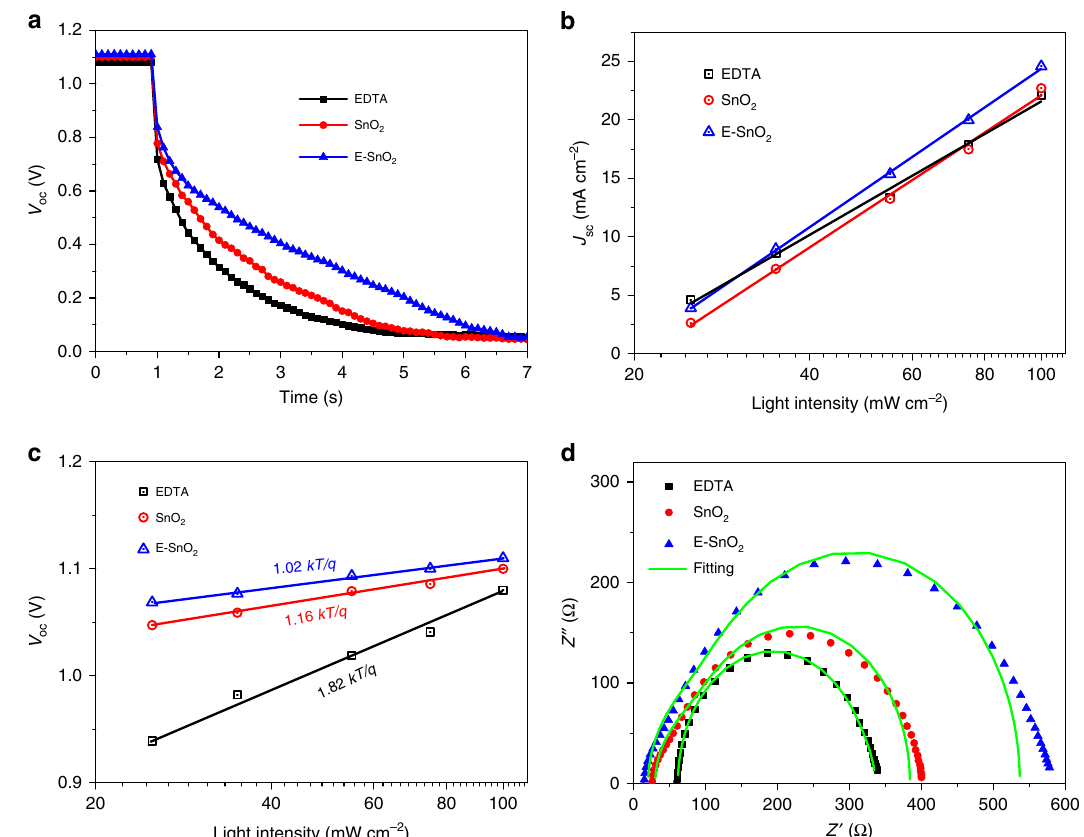
Fig. 5 Charge transfer properties of the planar-type PSCs using different ETLs. a V oc decay curves, b J sc vs. light intensity, c V oc vs. light intensity, and d EIS of planar-type PSCs with various